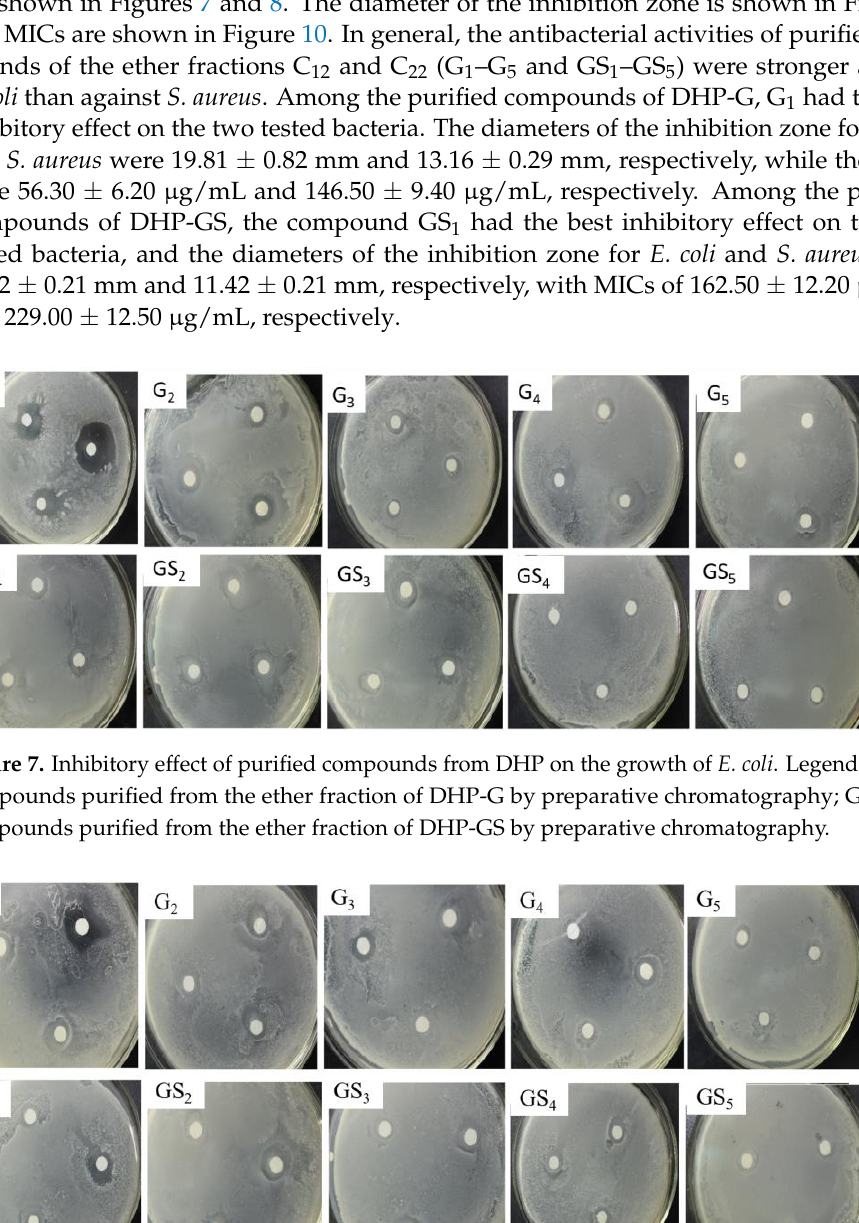
Figure 9. Inhibition zone diameter of purified compounds from DHP on E. coli and S. aureus.